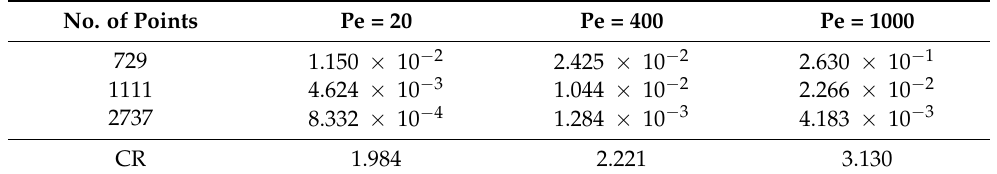
Table 13. Example No. 3—values of RMSE and the convergence rates